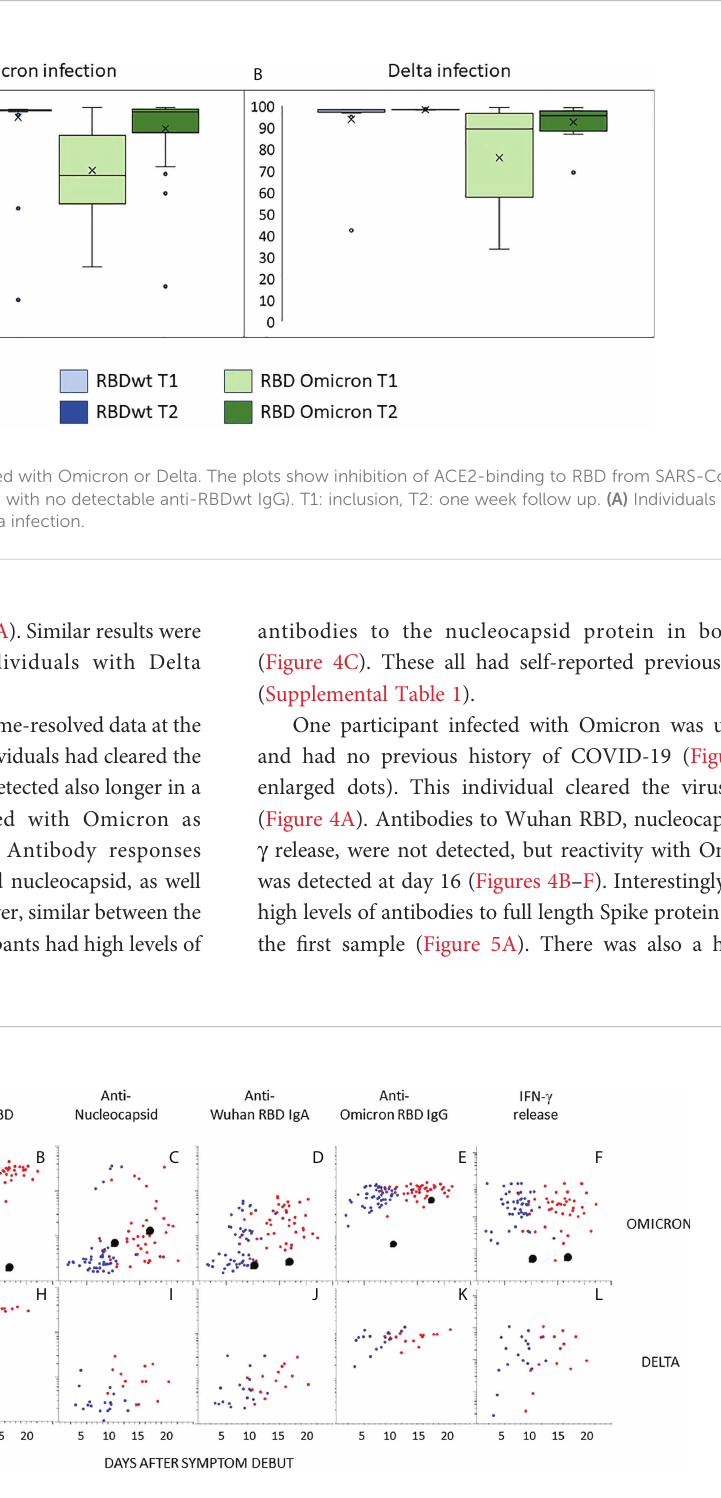
FIGURE 4 Kinetics of antibody responses in individuals infected with Omicron or Delta. The scatter plots show individual data after infection with Omicron (A – F) or Delta (G – L) plotted at days after symptoms onset. (A, G) Viral load in nasopharyngeal swabs. (B – E) and (H – K) Relative levels of antibodies to indicated antigen (y-axis, log10). (F, L) T-cell responses by IFN g release assay. Blue and red dots indicate the fi rst and second sample obtained at 4-14 days intervals, respectively. Enlarged black dots indicate samples from an unvaccinated individual obtained at 9 or 16 days after symptom onset. Source data are found in Supplemental Table